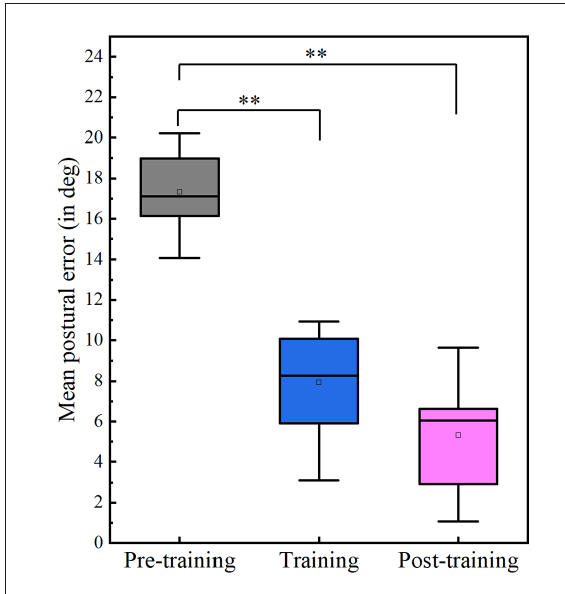
FIGURE3 Box plot for change in mean postural error during different phases: Postural error during training and post-training phases is significantly less than in pre-training phases. Double asterisks signify the p -value < 0.01. There is no significant difference between the training and the post-training phase ( p > 0.1).